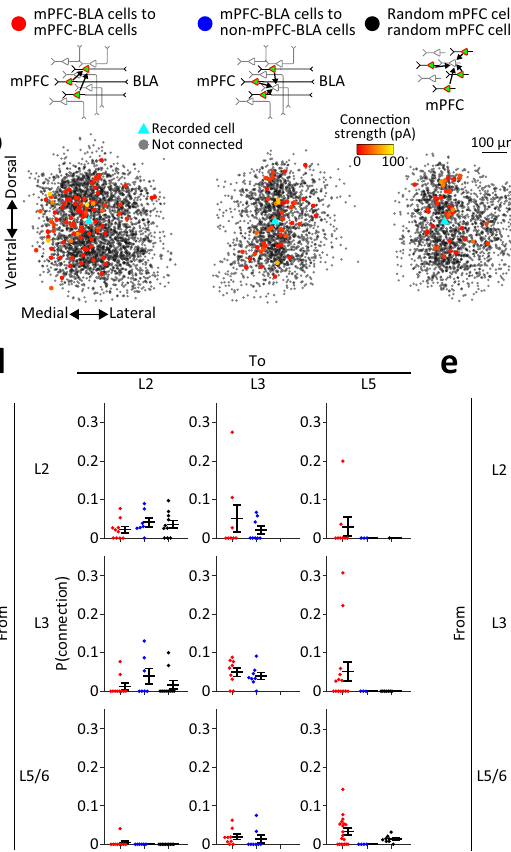
=0.003. n recordedcellsforeachconditionisindicatedundertheplot.In c – e ,error bars indicate mean ± SEM. d Probabilities of cross-layer synaptic connections. Notice that stimulated (presynaptic) cells in layers 5 and 6 were pooled. n cells for mPFC-BLAtomPFC-BLAcellconnections:10L2 → L2,10L3 → L2, 9L5/6 → L2,8L2 → L3, 9 L3 → L3, 9 L5/6 → L3, 8 L2 → L5, 14 L3 → L5, 19 L5/6 → L5. n cells for mPFC-BLA to non- mPFC-BLA cell connections: 7 L2 → L2, 7 L3 → L2, 6 L5/6 → L2, 8 L2 → L3, 8 L3 → L3, 8 L5/ 6 → L3, 3 L2 → L5, 3 L3 → L5, 4 L5/6 → L5. n cells for random mPFC to random mPFC cell connections: 10 L2 → L2, 10 L3 → L2, 10 L5/6 → L2, 0 L2 → L3, 0 L3 → L3, 0 L5/6 → L3, 1 L2 → L5, 7 L3 → L5, 8 L5/6 → L5. e Strengths of cross-layer synaptic connections, pre- sented as mean amplitude of all connections found in the corresponding layers. n cells are as in d . Source data are provided as a Source Data fi